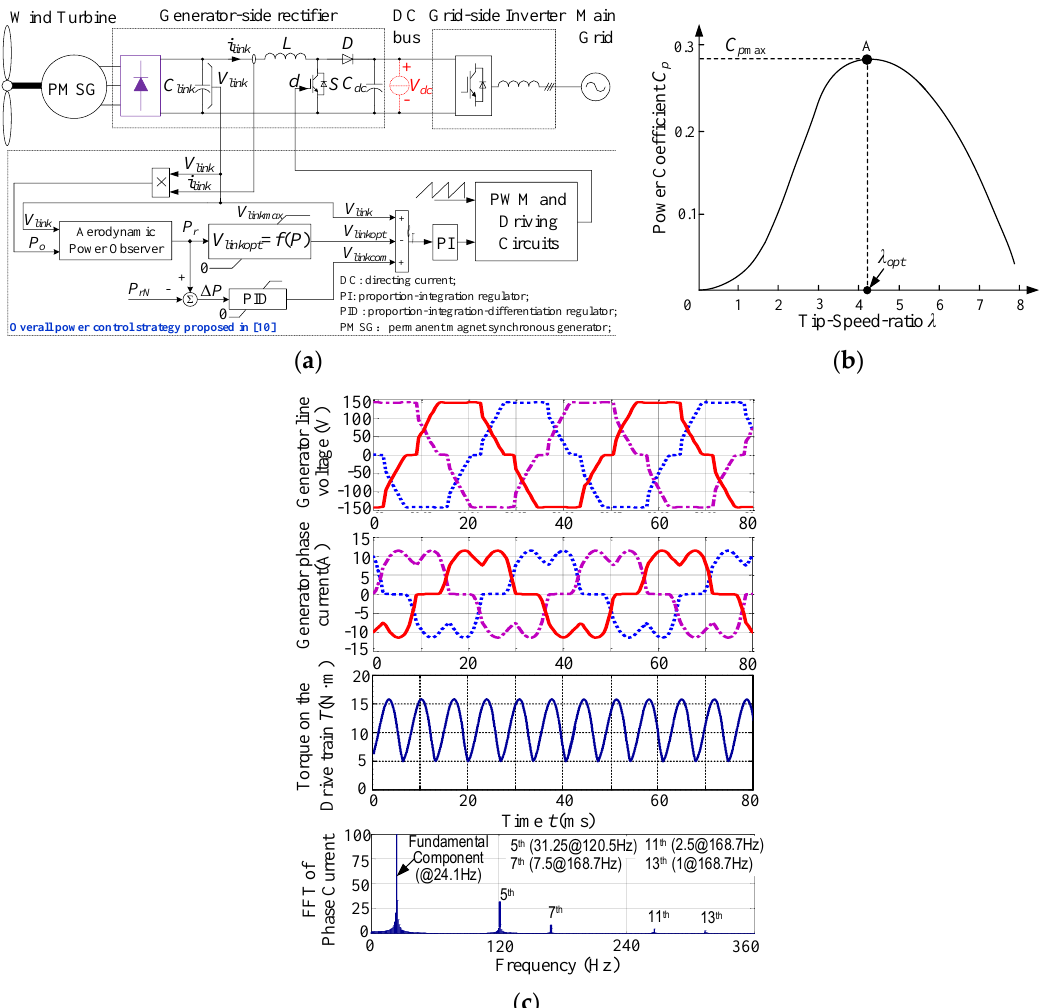
Figure 1. Wind energy conversion system. ( a ) structure with diode rectifier; ( b ) power coefficient curve of the turbine; ( c ) tested results of generator voltage, current, and shaft torque, and Fast Fourier Transformation (FFT) analysis of the generator current.